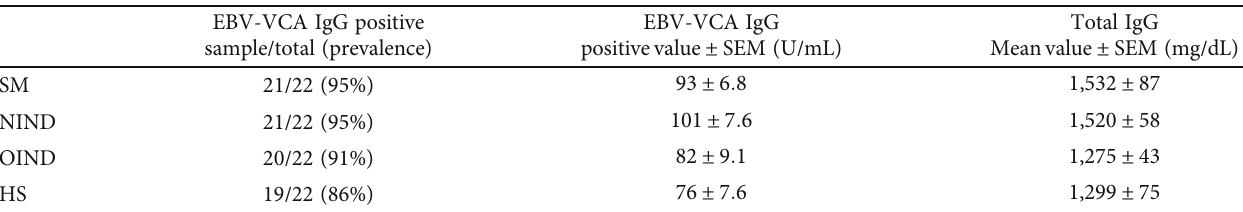
Figure 3: Total IgG variability in sera from MS, NIND, OIND, and HS. Data are graphed as scatter dot plot where IgG mean values and their standard error mean (SEM) are marked by short horizontal lines. The IgG levels were not statistically di ff erent among the cohorts ( p > 0 : 05 ). Table 4: EBV-VCA IgG prevalence and total IgG antibodies detected in serum samples from MS patients, NIND, and OIND compared to HS.